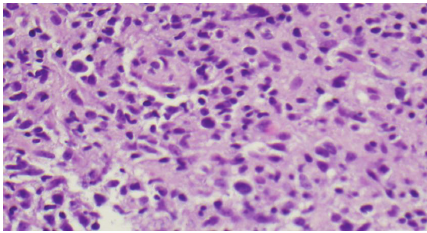
Figure 5: High power view of bronchial biopsy. The small to large atypical lymphocytes have pleomorphic, hyperchromatic nuclei, and distinct nucleoli. Scattered plasma cells and histiocytes are